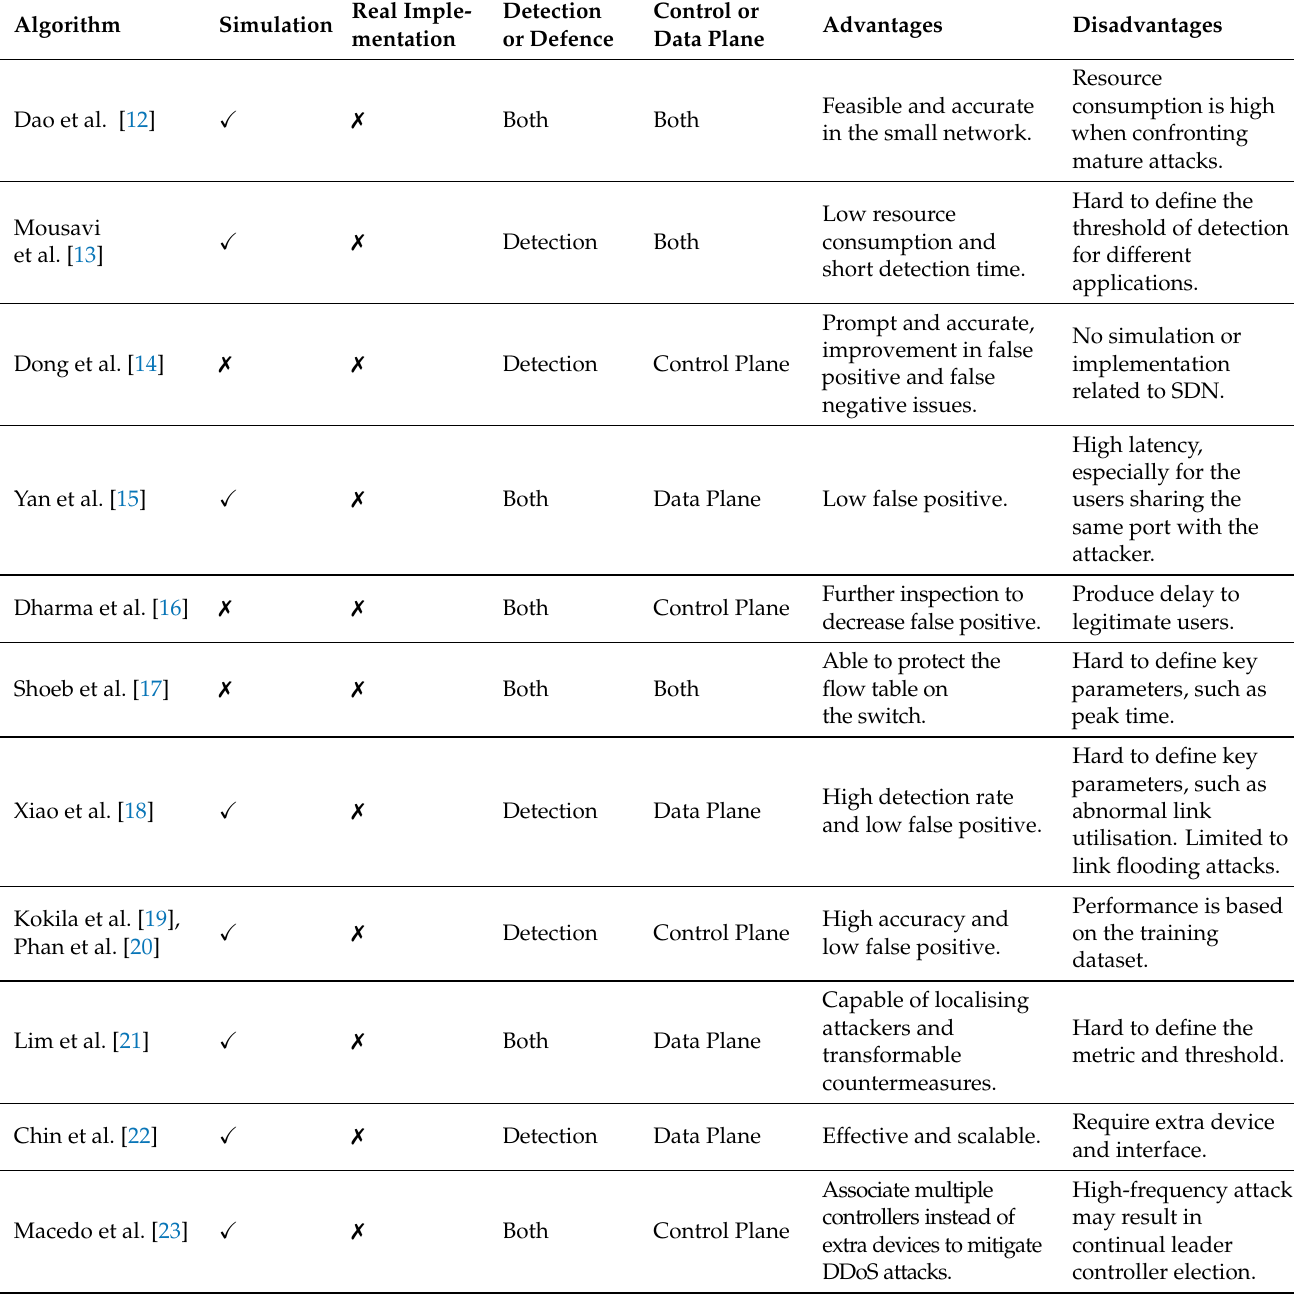
Table 1. Existing solutions for detecting and defending Software-Defined Networking (SDN) against Distributed Denial of Service (DDoS)